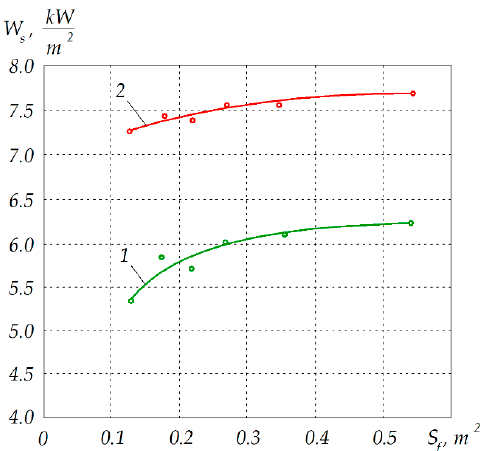
Figure 4. The dependences of power 𝑊 𝑠 distributed on the hearth area S f for a range of models of Nabertherm furnaces designed for sintering ceramics with maximum operating temperatures: 1— 𝑇 𝑚𝑎𝑥 = 1400 °C; 2— 𝑇 𝑚𝑎𝑥 = 1600 °C.